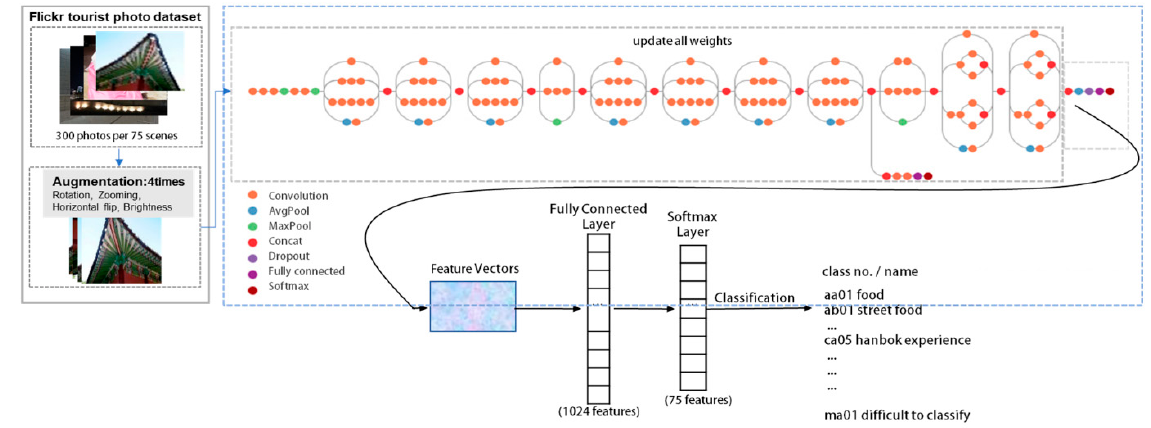
Figure 2. Architecture of fine-tuned Inception-v3 model.